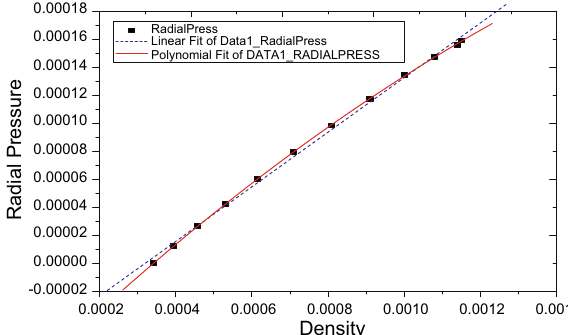
Fig. 13 Variation of p r with ρ for PSR J0348+0432 with β = 1 (the solid line (red) denotes quadratic fit and the dashed line (blue) denotes linear fit)